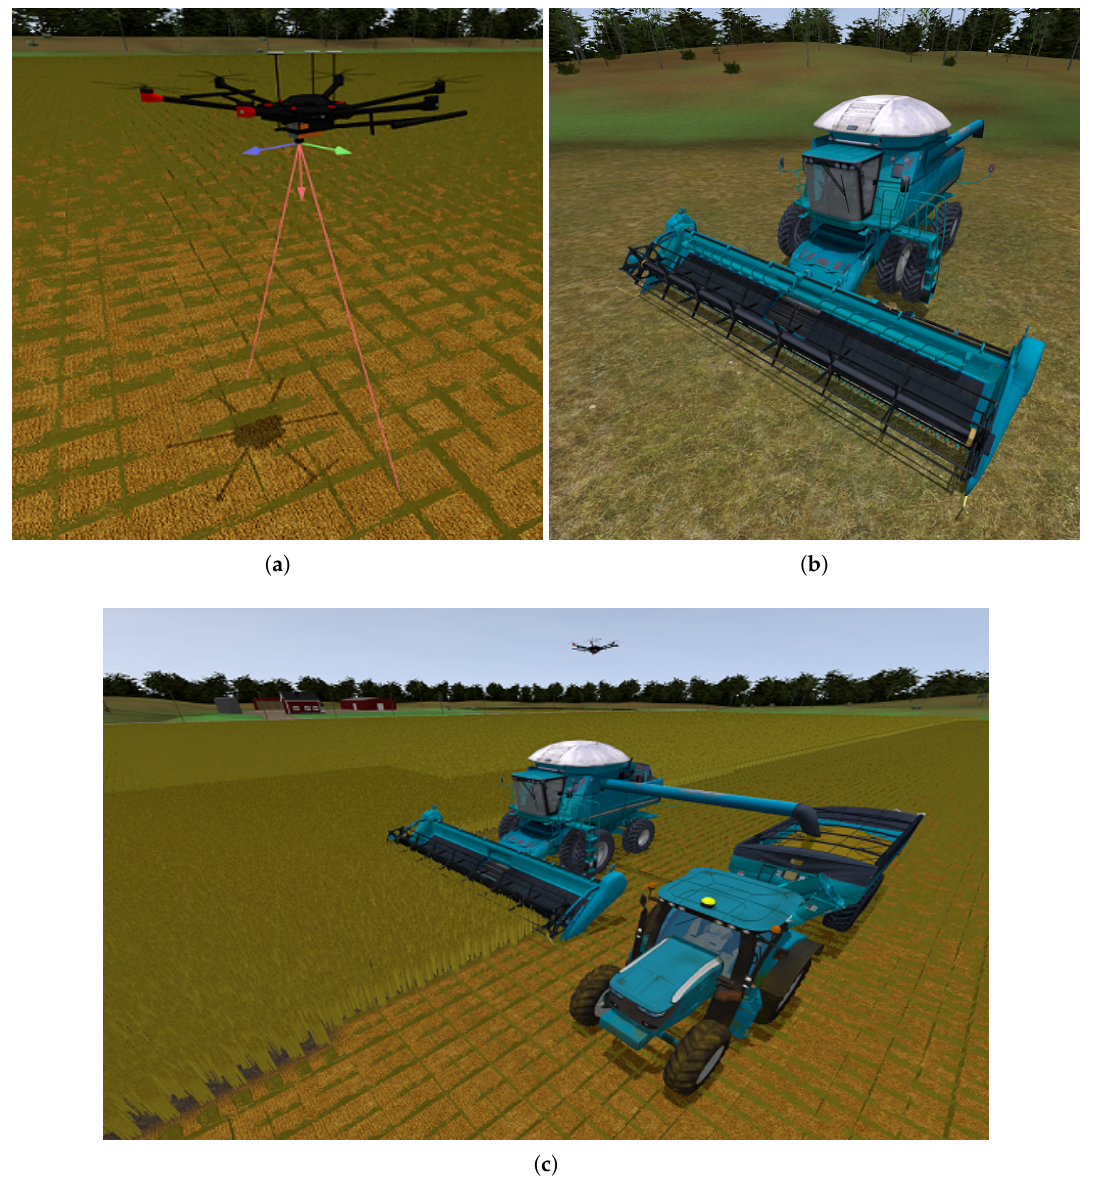
Figure 3. Farming simulation environment and machinery representation. ( a ) Drone representation; ( b ) combine-harvester representation; ( c ) drone, combine-harvester and tractor representation, together with a simulated farming